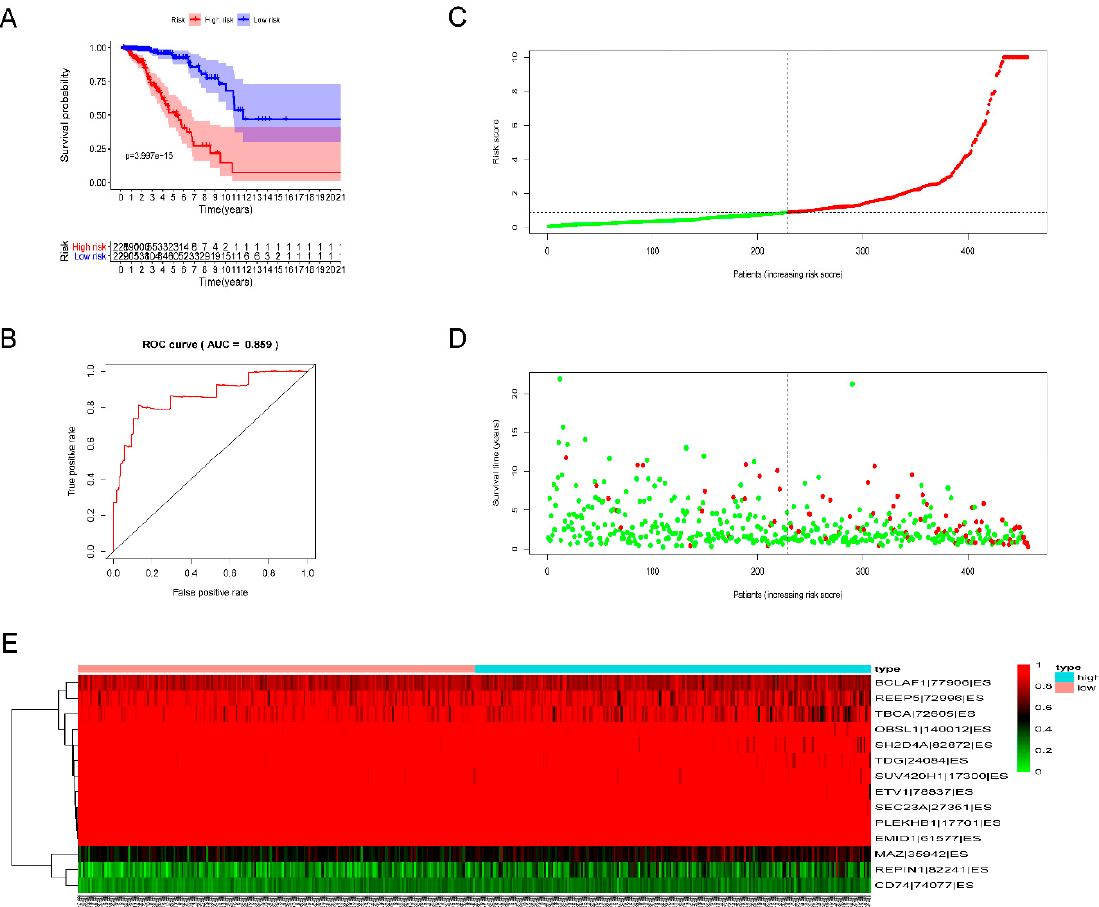
Figure 4. Analysis of the prognostic signature (PS)–exon skip (ES). The 14 prognosis-associated events of ES were selected by multivariate Cox regression analysis to make the PS–ES model. ( A ) Kaplan–Meier (KM) curves of prognostic signature built with ES events. ( B ) The receiver operating characteristic (ROC) curves of prognostic signatures constructed with ES events ( C ). Risk scores of GBC patients constructed by ES events. ( D ) Survival conditions and survival time of GBC patients, distributed according to risk score (green dots represent survivors, red dots represent deaths). ( E ) Heat map indicating the correlation between the percent-spliced-in (PSI) value of the ES events and the risk score. Colors from red to blue means decreasing PSIs from high to